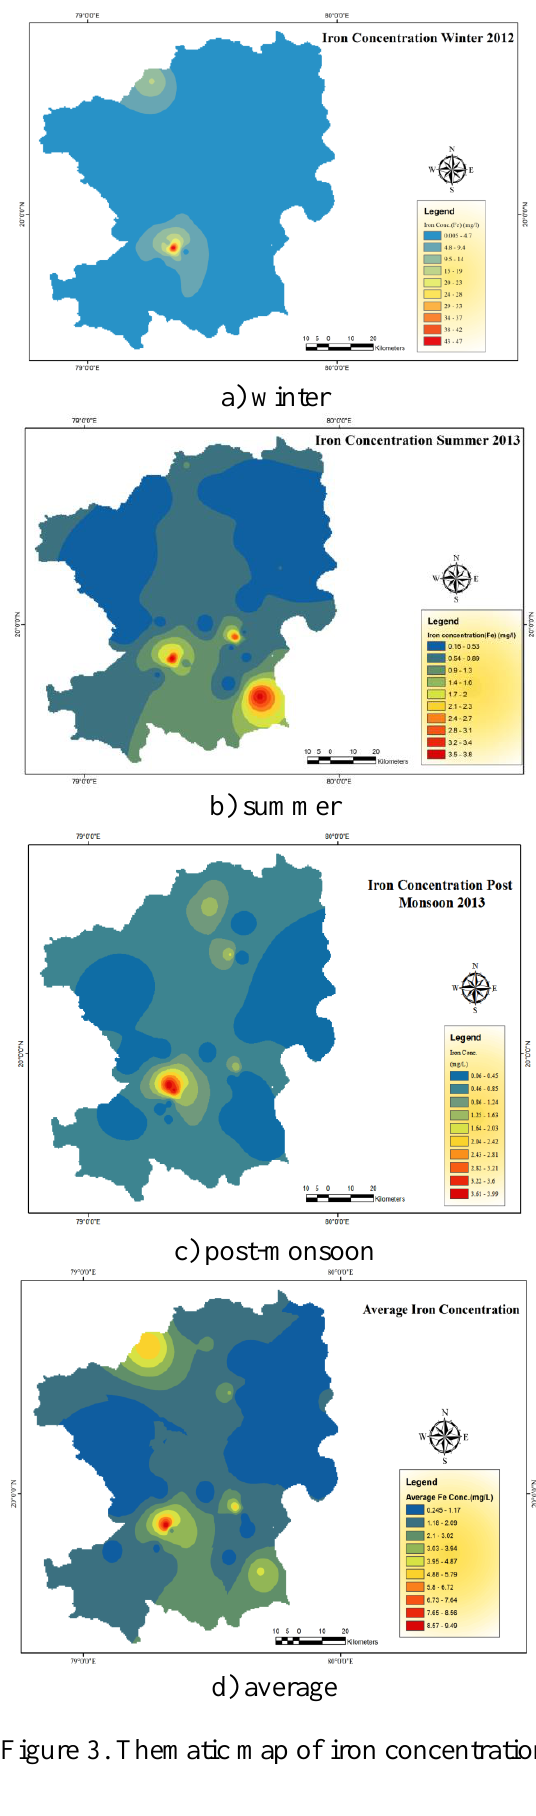
Figure 3. Thematic map of iron